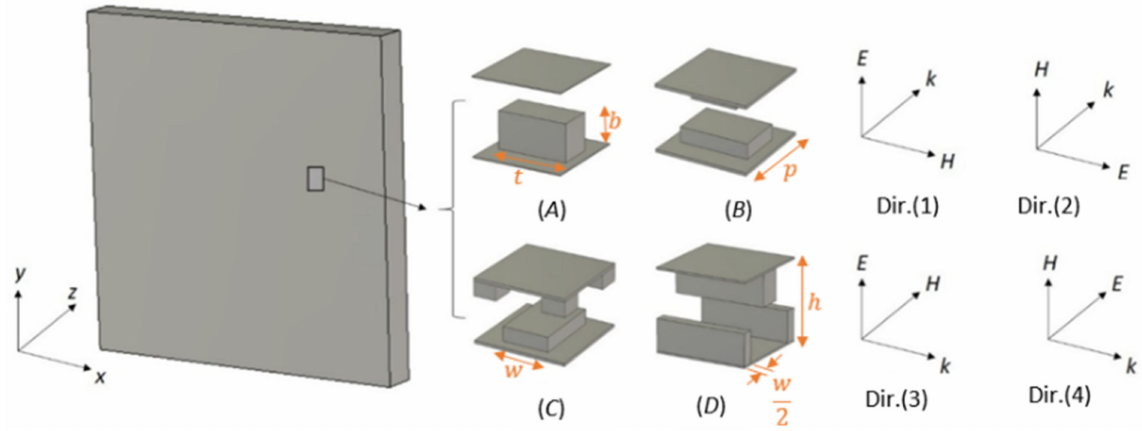
Figure 1. The investigated unit cells with their slab plane perpendicular to the wave incidence at four propagation directions.